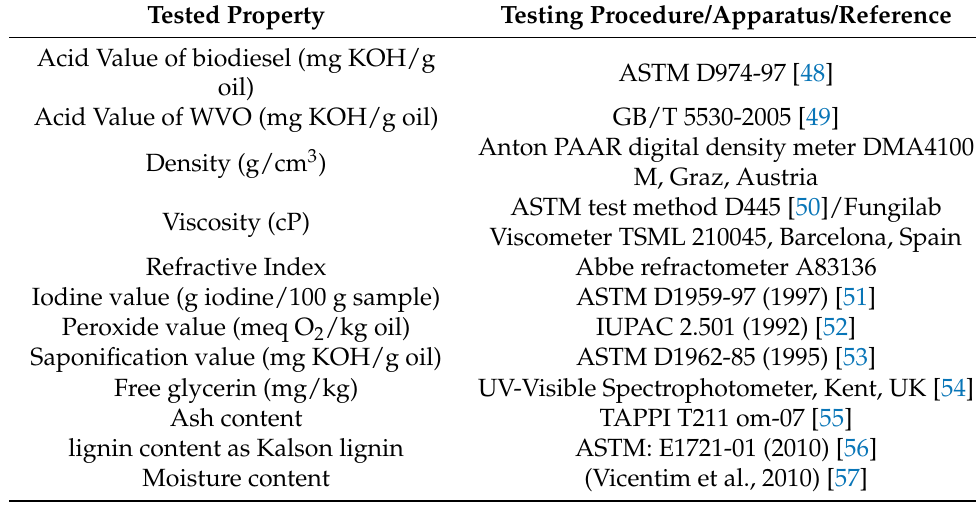
Table 1. Standard Methods and Equipment Used for Physical Properties Measurements. Tested